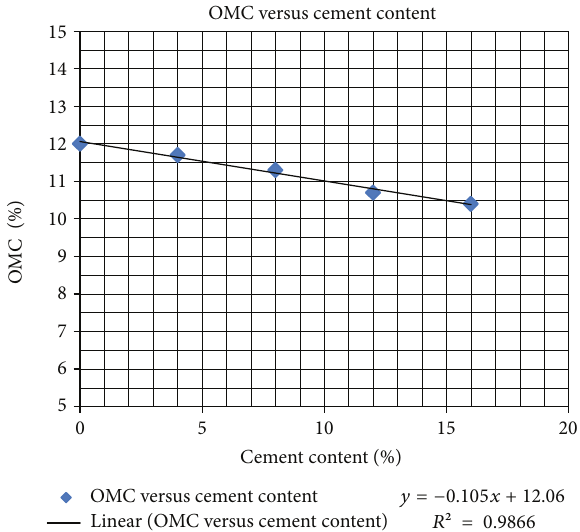
Figure 6: Relationship between optimum moisture content and cement content for stabilized WDA.